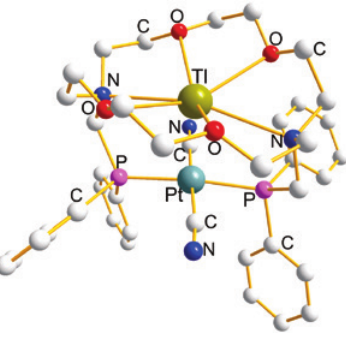
Pt II ( μ - η 2 : η 6 -crownP 2